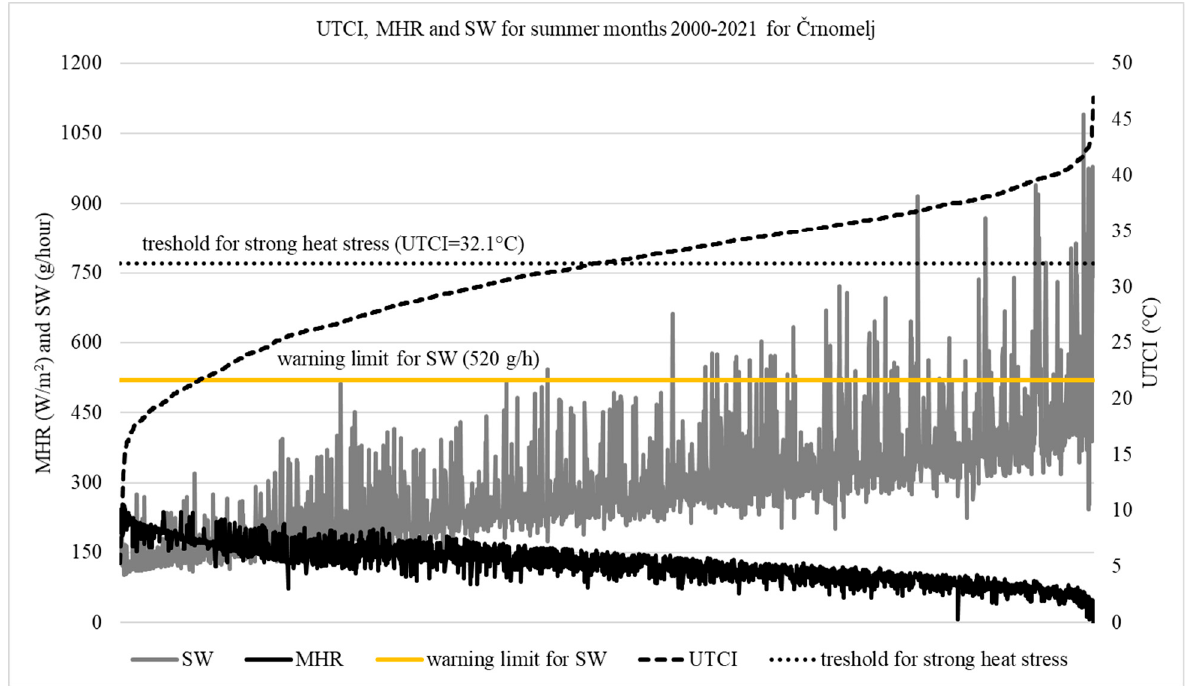
Figure 5. Values of Universal Thermal Climate Index (UTCI), accepted level of physical activity (MHR) and water loss index (SW) for each summer day in the period 2000–2021 in Č rnomelj, ordered by increasing UTCI, and denoted UTCI threshold for strong heat stress and warning limit for SW.